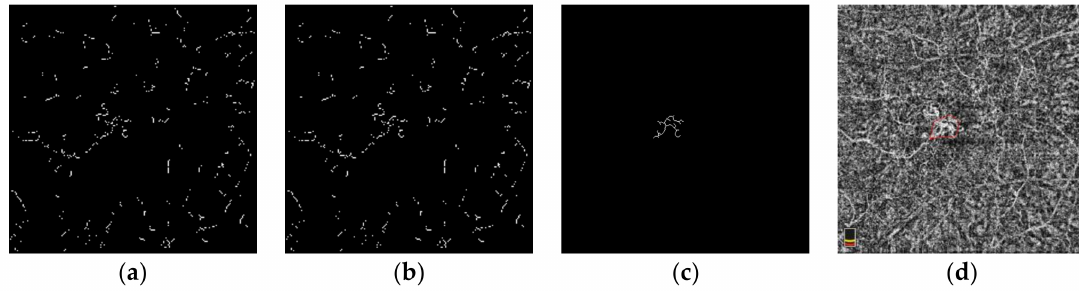
Figure 6. An example of choroidal neovascularization (CNV) detection: ( a ) Thinning, ( b ) endpoint connection, ( c ) eccentricity, and ( d ) output